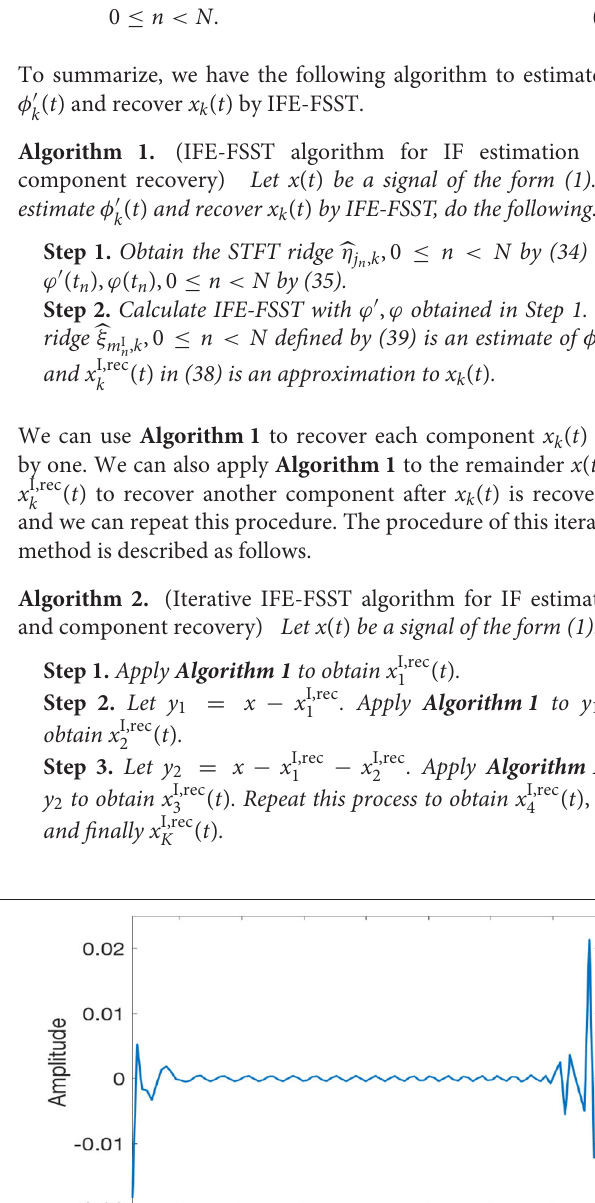
Frontiers in Applied Mathematics and Statistics |